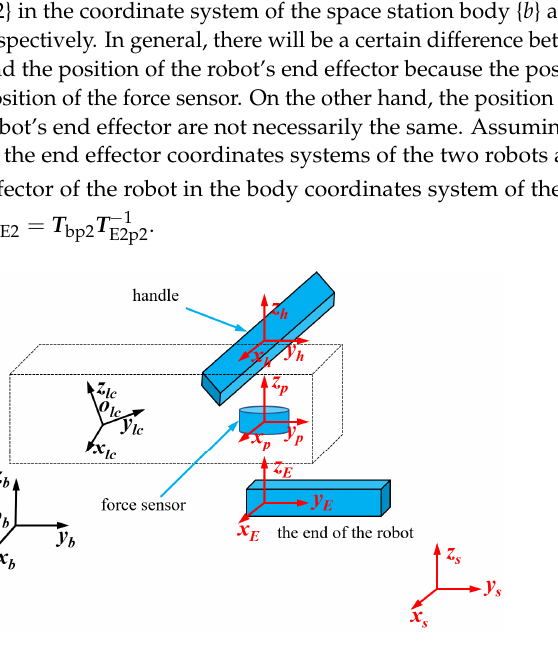
Figure 3. Schematic diagram of robot coordinates system.